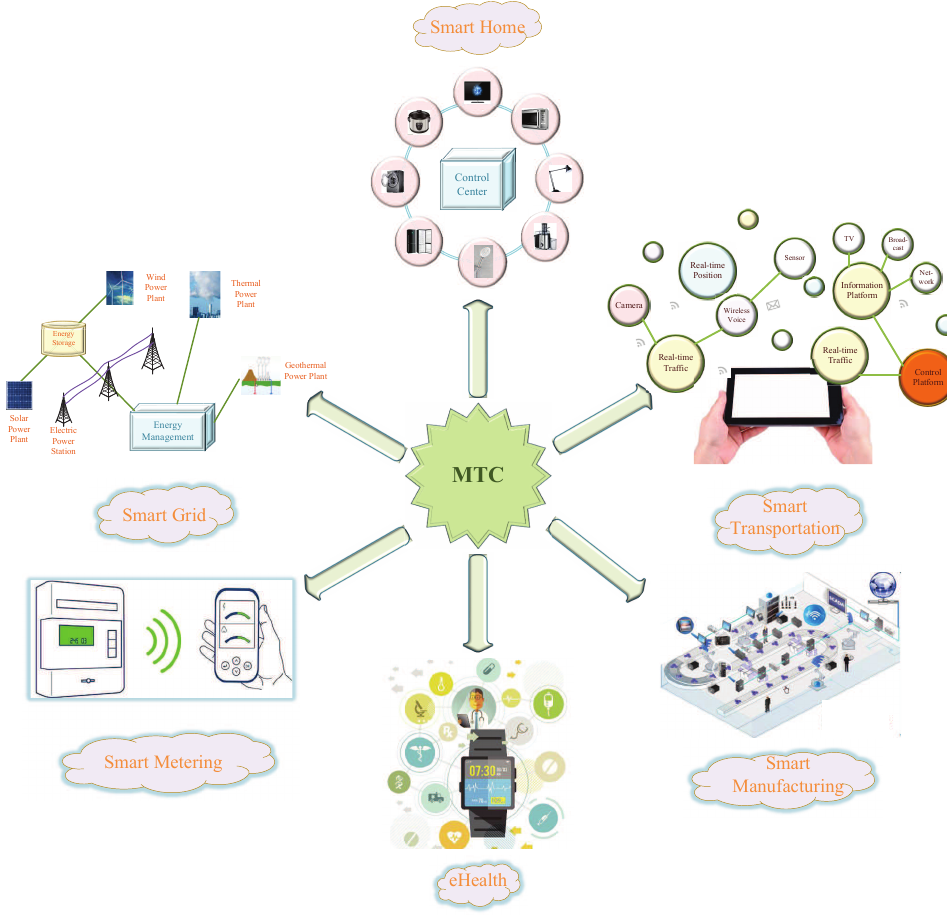
Figure 1. The specific application scenarios for